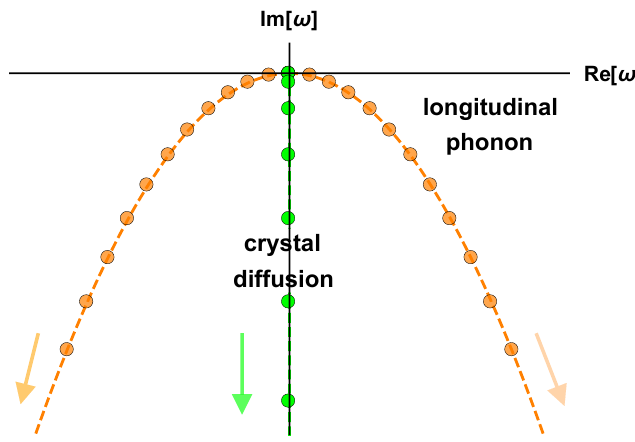
Figure 1 . A sketch of the two hydrodynamic modes appearing in the longitudinal sector of the QNMs of our system. In orange the longitudinal damped sound ! = (cid:6) c L k (cid:0) i D p k 2 and in green the di(cid:11)usive mode ! = (cid:0) i D (cid:8) k 2 . The arrows indicate the tendency when increasing the momentum k